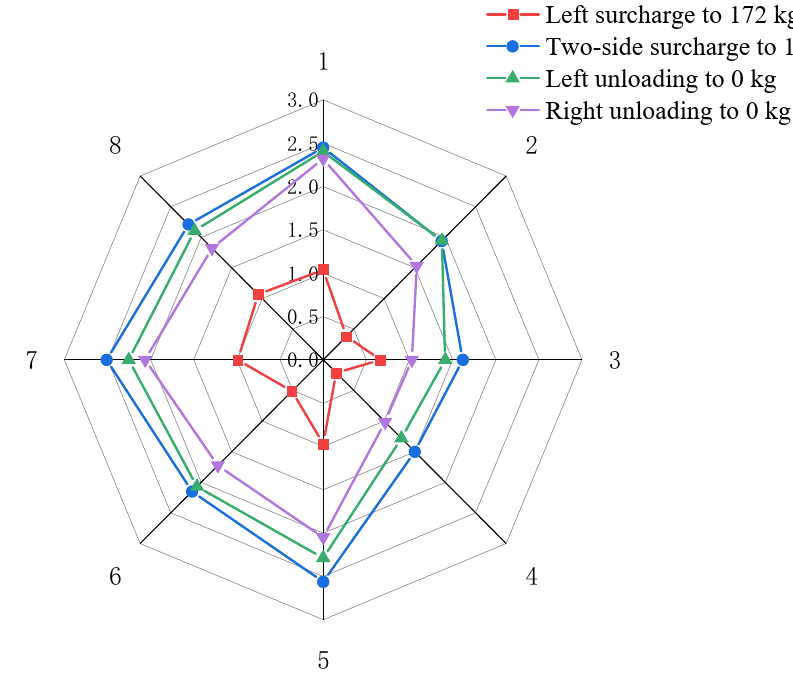
Figure 21. Variation in additional surrounding pressure under different surcharges for Case 4 (unit: kPa).